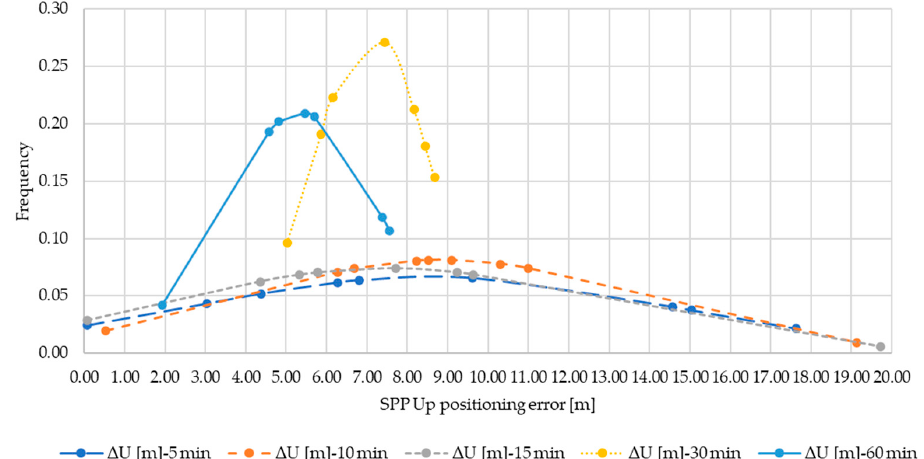
Figure A5. Normal distribution ∆ N for SPP.